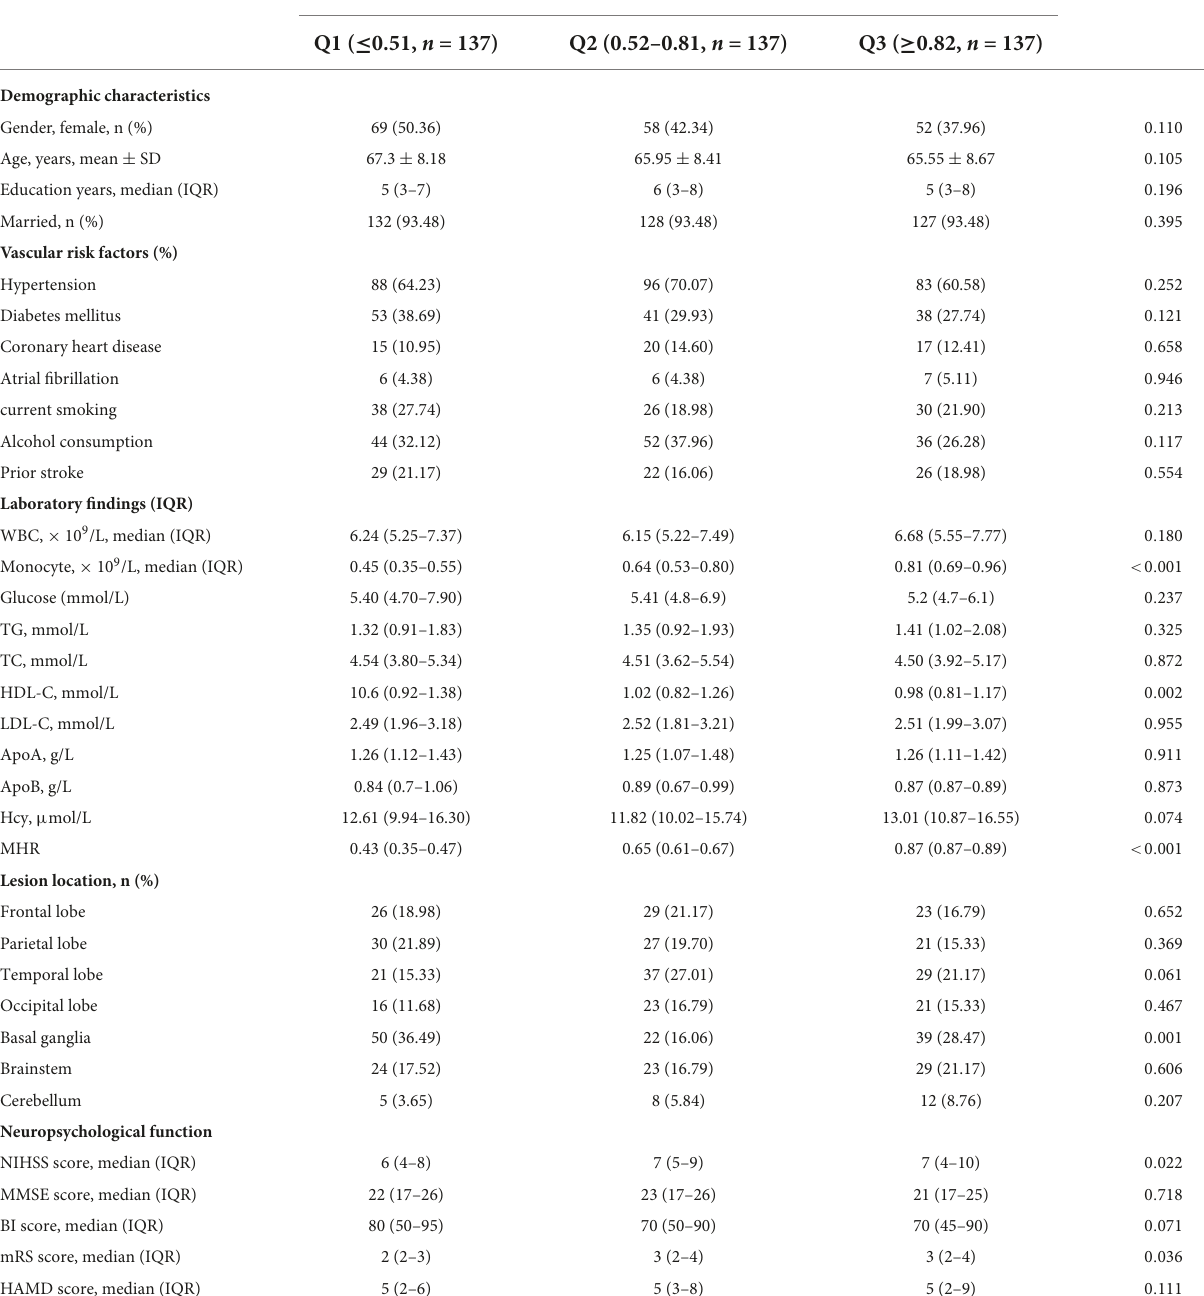
TABLE 2 Baseline characteristics of patients with AIS according to MHR